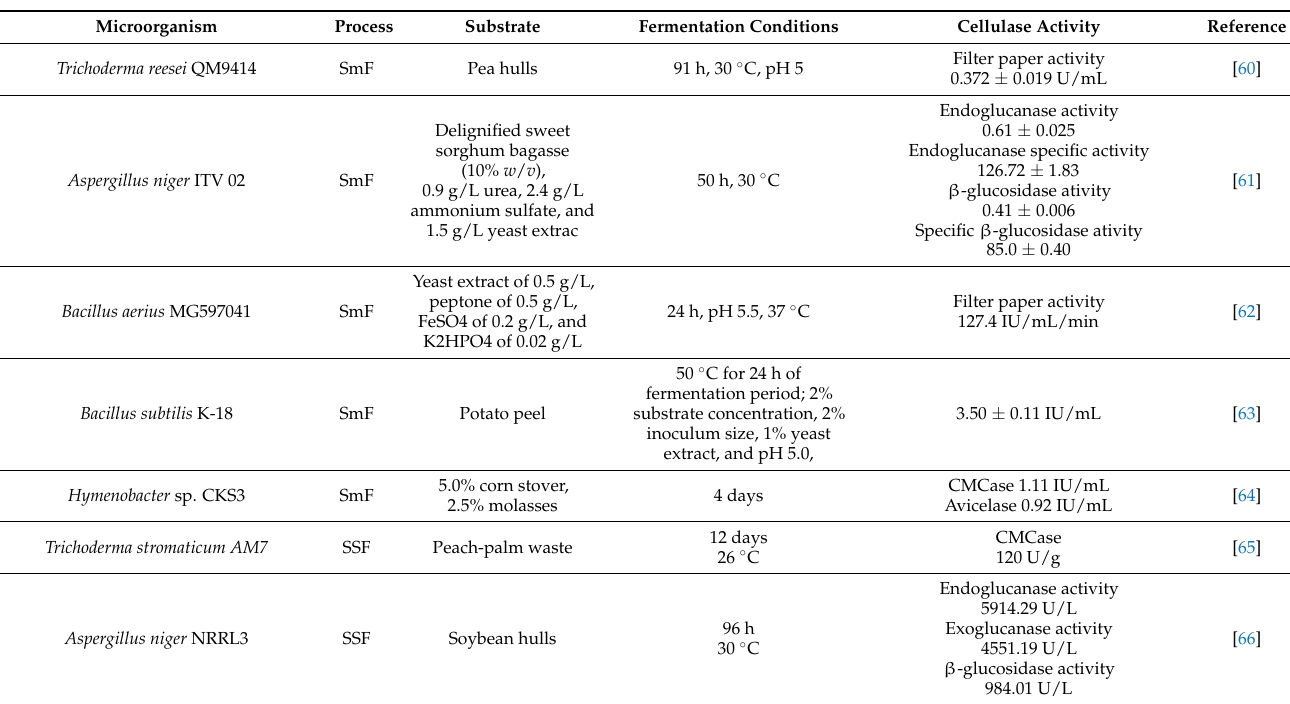
Table 1. Review of fermentation parameters, microorganisms used in SmF and SSF, as well as obtained cellulase